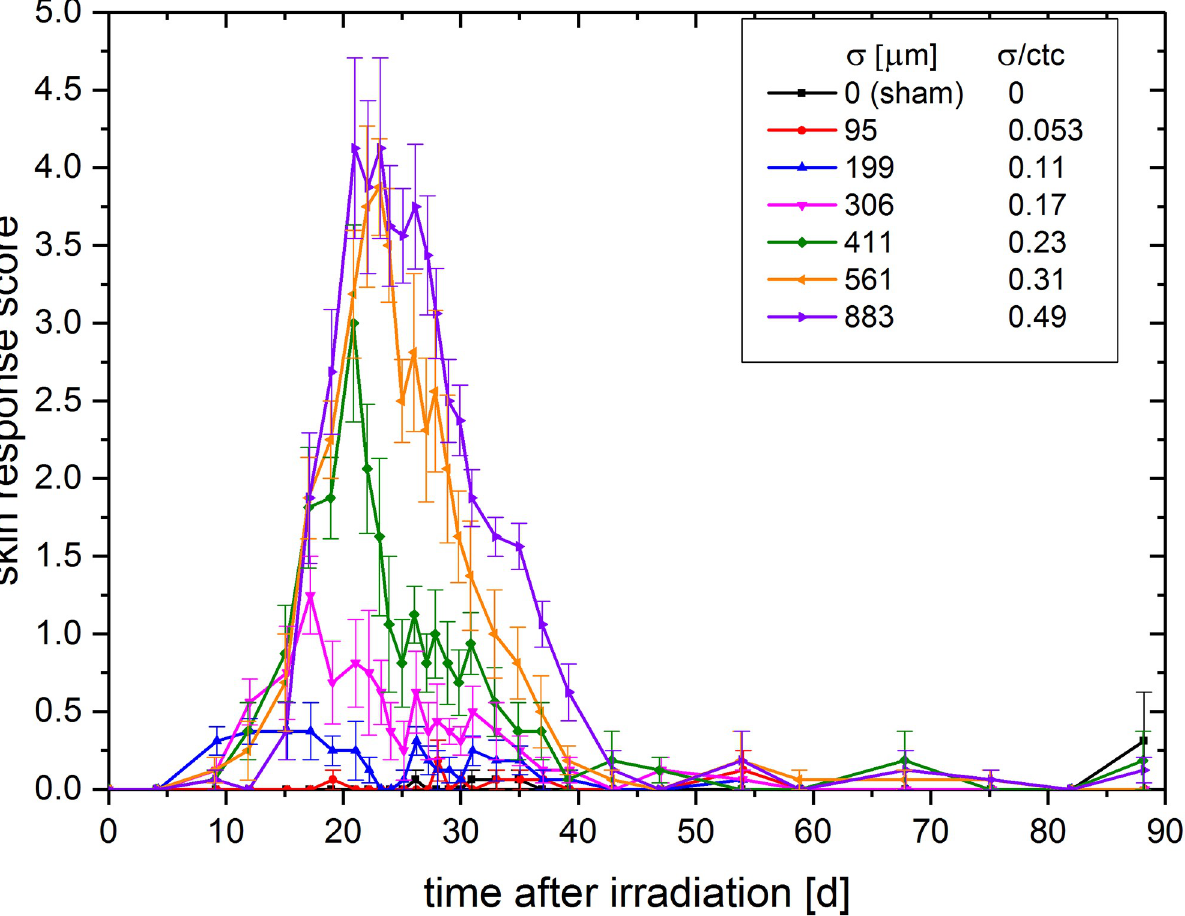
Fig 4. Mean score over monitoring time (sum of desquamation and erythema score ± SEM).